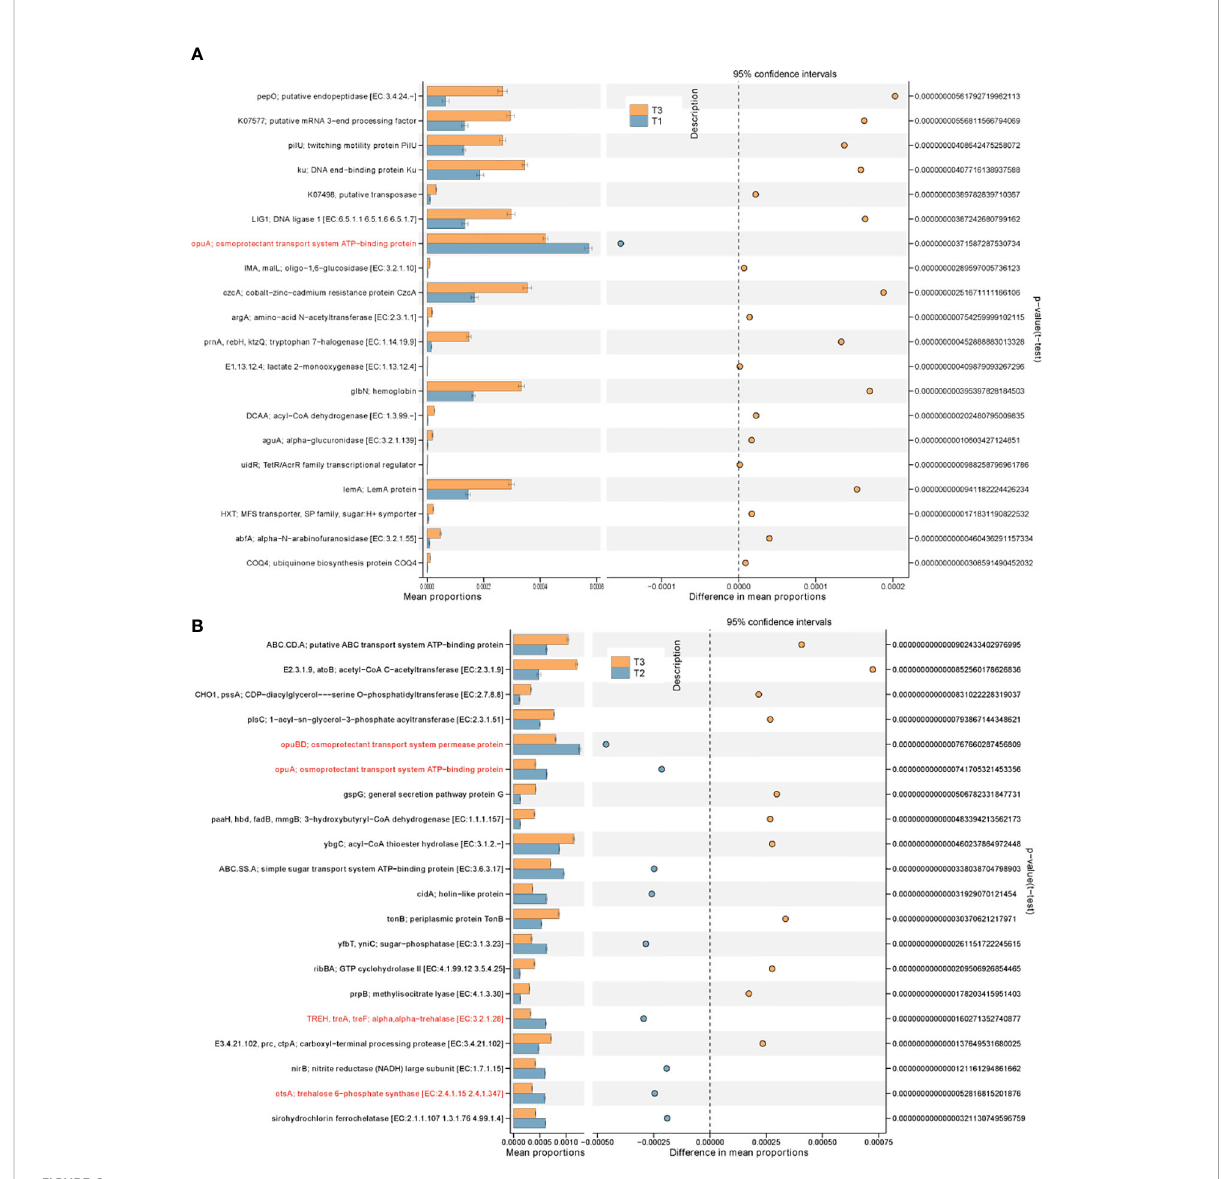
FIGURE 6 PICRUSt predicted metagenome functions with signi fi cant difference in abundance between groups at KO level. (A) T1 vs. T3; (B) T2 vs.